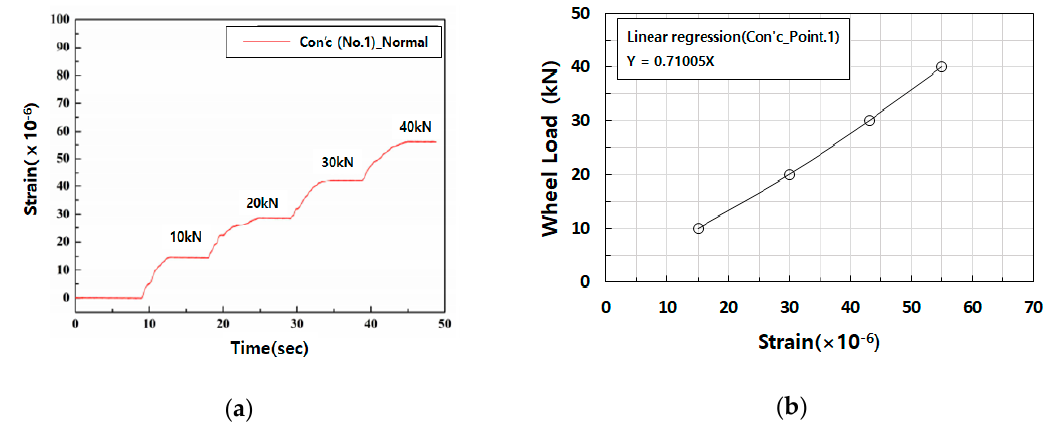
Figure 8. Wheel load calibration result and linear regression graph. ( a ) Result of calibration; ( b ) Linear regression.